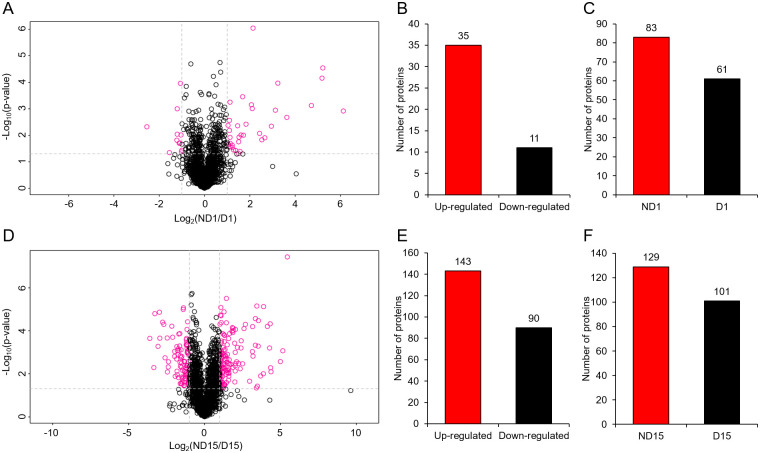
Comparisons of protein expression patterns between non-diapause-(ND) and diapause-destined (D) pupae of Bactrocera minax.(A-C) Differentially abundant proteins (DAPs) in ND1 vs D1 comparison. (D-F) DAPs in ND15 vs D15 comparison. (A and D) Volcano plot of log2 fold-change vs -log10
p value in each comparison. Fold change > 2 and p < 0.05 were set as the threshold for significant differential abundance. (B and E) Number of proteins that were detected in both ND and D groups with significantly different abundance. (C and F) Number of proteins that were.